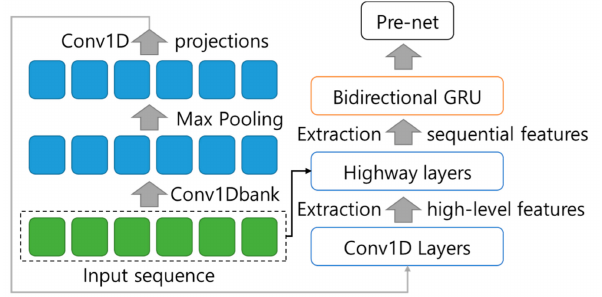
Figure 7. The structure of the convolution bank + highway net + bidirectional gated recurrent unit